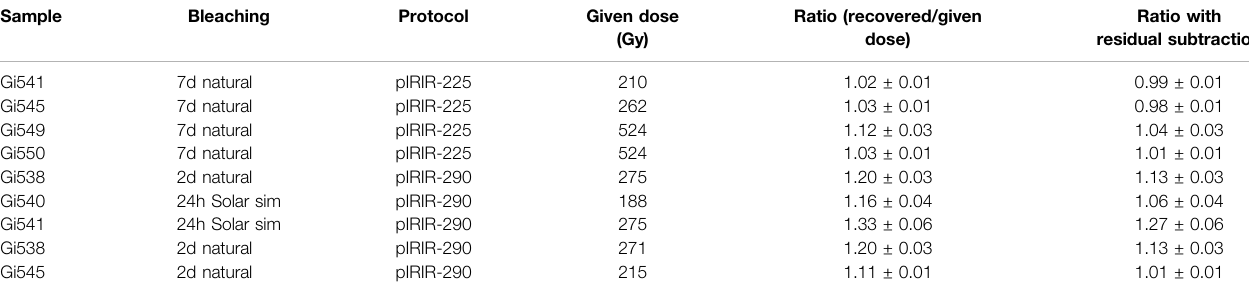
TABLE 3 | Results of dose recovery tests using a pIRIR-225 and a pIRIR-290 protocol. Sample